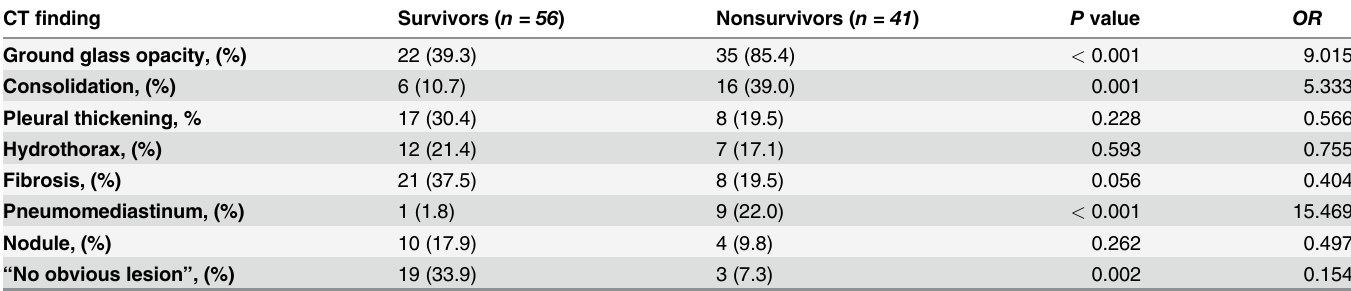
Table 2. Eight Lung CT Findings during the First 5 Days after PQ Intoxication.